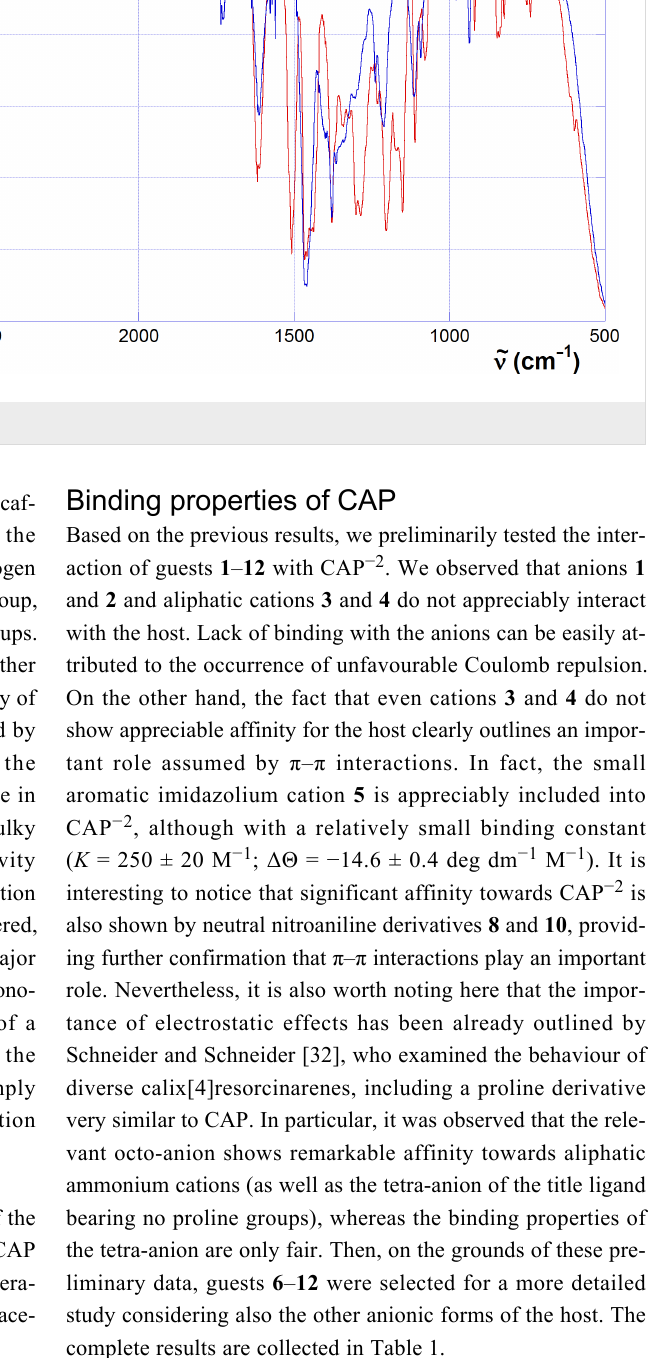
Figure 5: FTIR spectra of preCA (red) and CAP (blue).